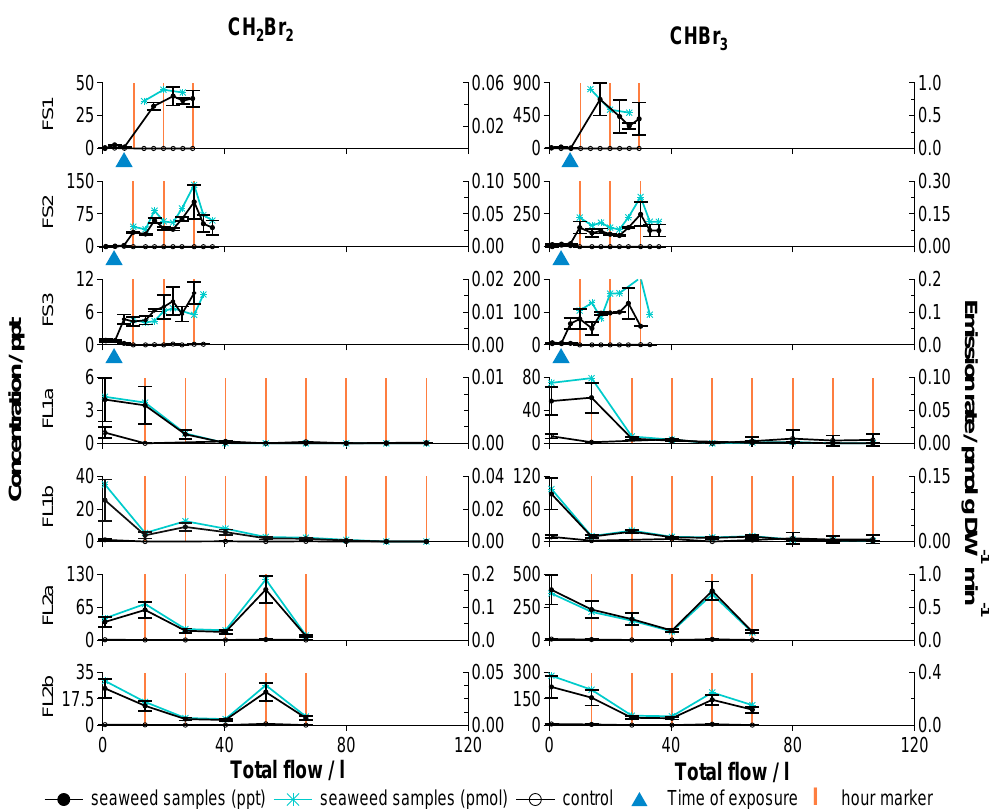
Figure 4. Bromocarbon concentrations (ppt, left axis) and production rates (pmolgDW − 1 min − 1 , right axis) observed in flasks during desiccation of F. vesiculosus . Changes are shown relative to total flow (L) for easier comparison between experiments that used different flow regimes (Sect. 2.2/Table 1). Experiments conducted at different times are denoted by individual numbers (e.g. FS1, FS2). Within these experiments replicates in different flasks (Fig. 1) are denoted by individual letters (FL1a, FL1b), see Table 1 for further details. Error bars are taken from the daily variations in calibration standards. Vertical lines = 1h intervals from start (0h) of desiccation. For experiments that began with submerged seaweed samples the exposure point is marked with a